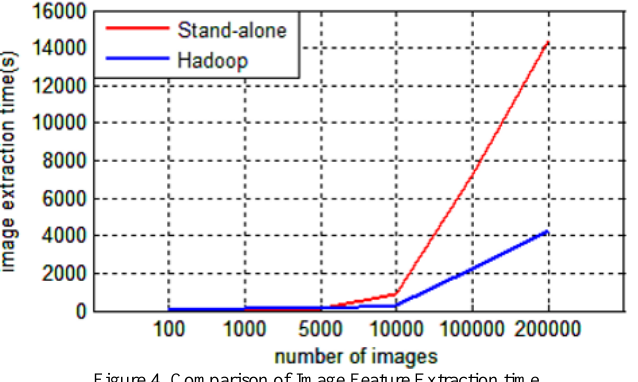
Figure 4. Comparison of Image Feature Extraction time